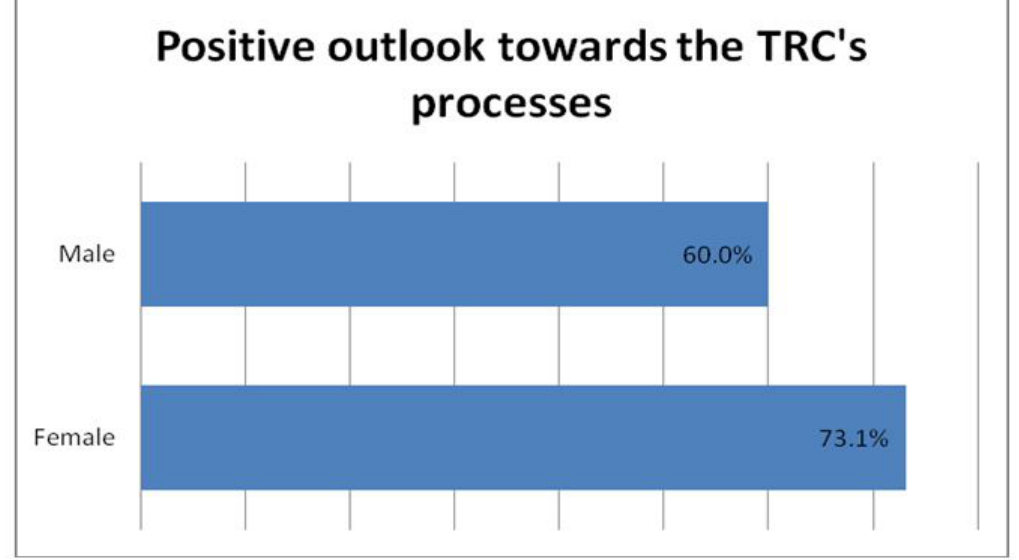
Figure 4: Comparing gender-based positive views about the TRC's